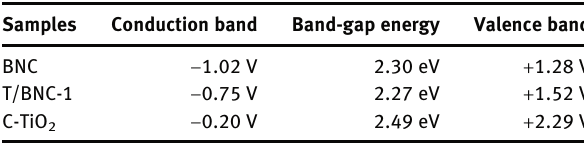
Table  : Conduction band and valence band positions ( vs. NHE) for BNC, C-TiO  and T/BNC-  .